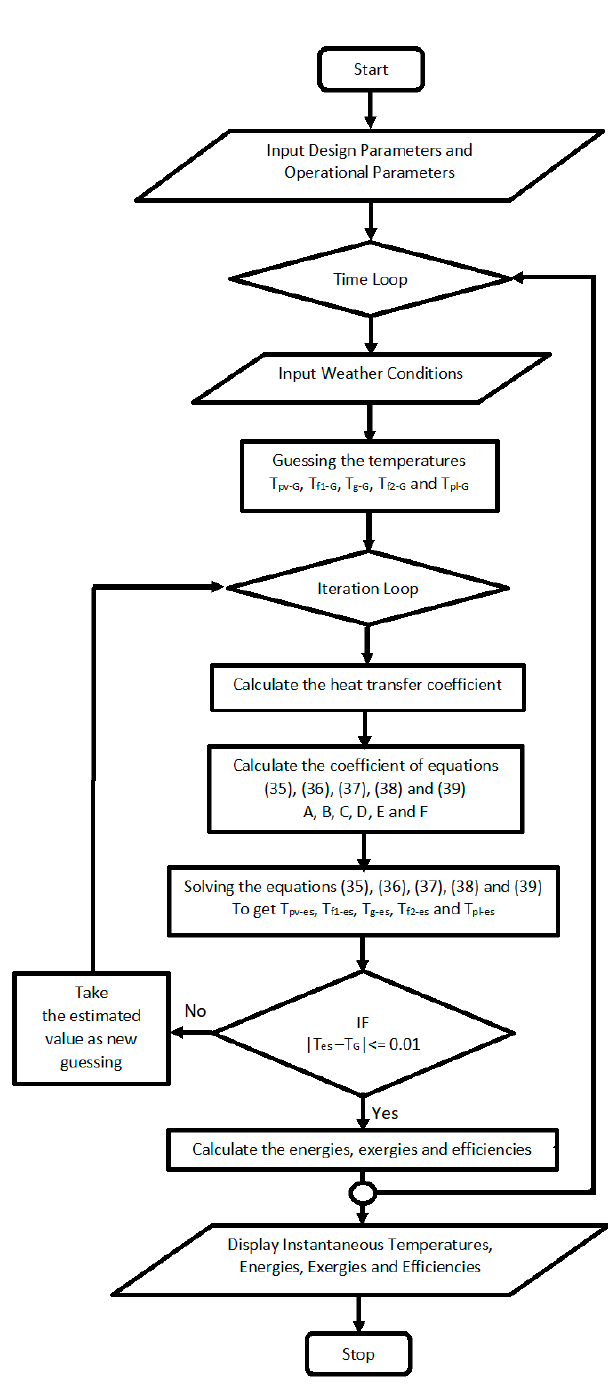
Figure 4. fl ow chart of simulation